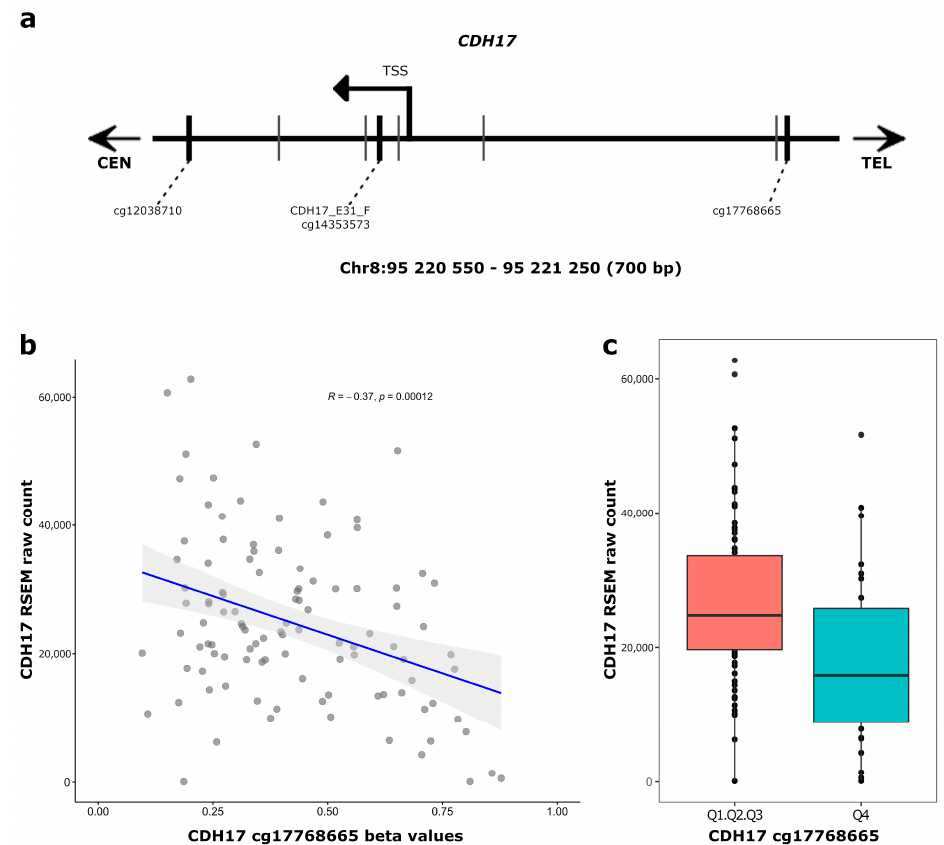
Figure 3. Correlation between DNA methylation and gene expression for CDH17 . ( a ) Map of the localization of the CpG sites in the DNA region Chr8:95220550-95221250 for the CDH17 gene. CpG sites cited in the study are represented by thick, black vertical lines and other CpG sites are represented by thin grey vertical lines. ( b ) Linear regression plot between the RNAseq expression level of CDH17 (RSEM raw count) and the methylation level (beta value) at the cg17768665 CpG site using data from the TCGA consortium for 108 stage II patients. The Pearson’s coefficient correlation (R) was − 0.37, and the p -value ( p ) was 0.00012 (indicated in the top of the plot). ( c ) Scatter plot of the RNAseq expression levels for CDH17 (RSEM raw count) for quartile groups Q1/Q2/Q3 (the cases corresponding of 75% lowest beta values for the cg17768665 CpG site) vs. quartile group 4 (the cases corresponding of the 25% highest beta values). A boxplot is represented for each